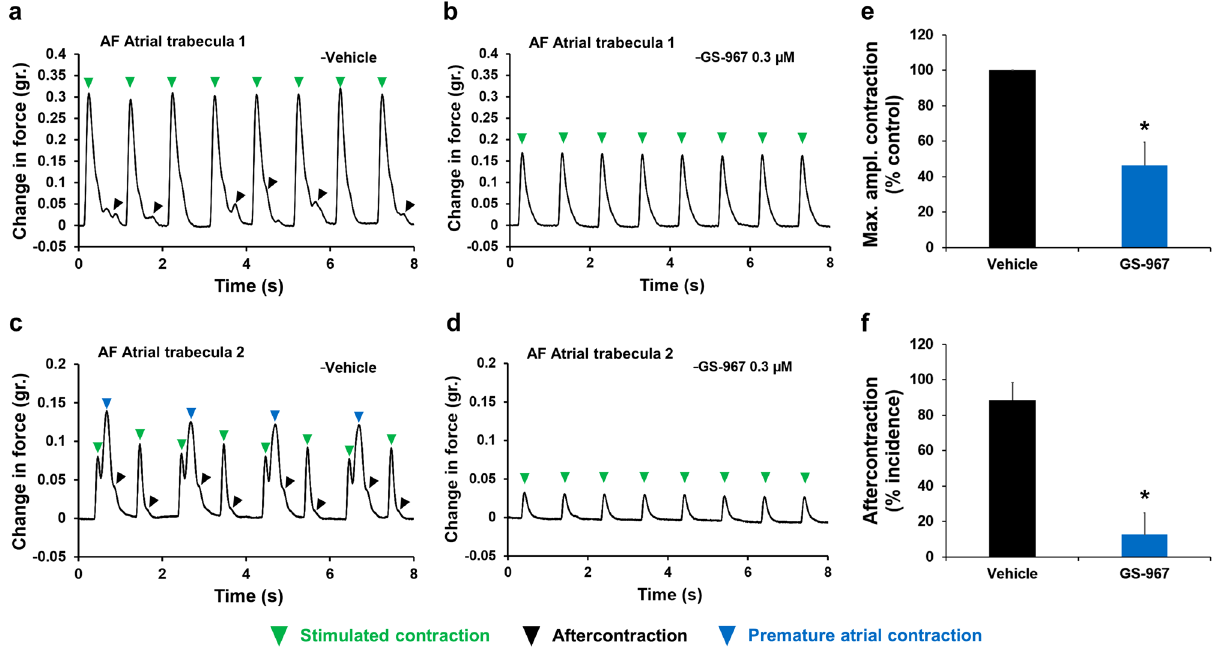
Figure 10. Effects of GS-967 on human atrial trabeculae contraction from donors with atrial fibrillation (AF) in condition of spontaneous arrhythmia. ( a – b ) and ( c – d ) show typical contraction/relaxation cycles